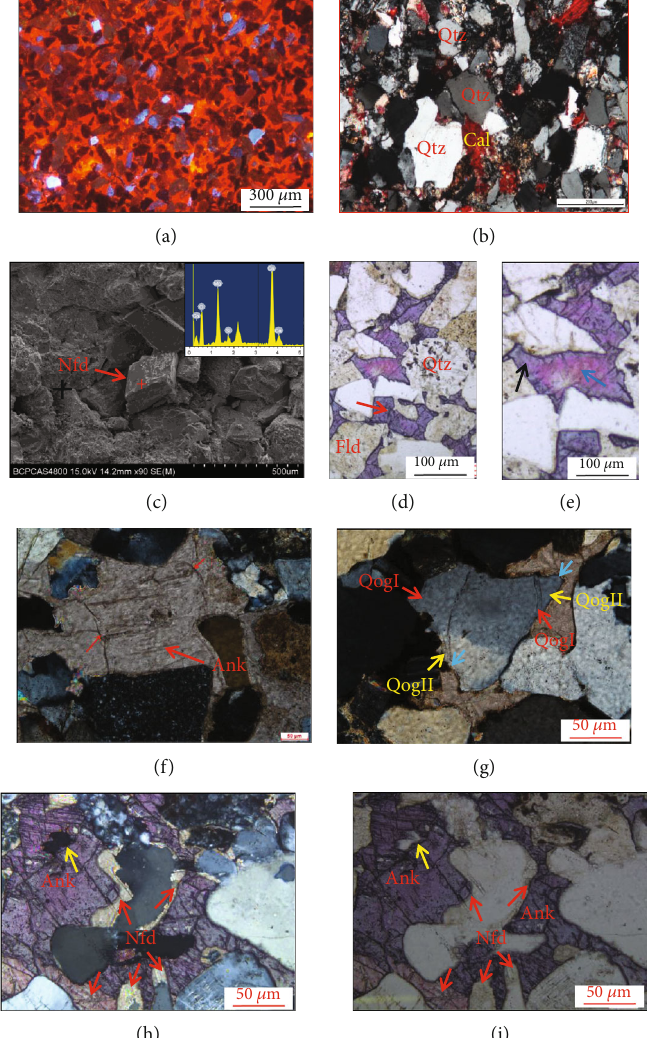
Figure 4: Diagenetic characteristics of the Es sandstones in Raoyang Sag. (a) Well L101: 3644.7m, a large deal of intergranular calcites acting 3 as orange cathodoluminescence, CL. (b) Well N35: 3758.7m, microcrystalline aggregates of calcite cements stained to be red, XPL. (c) Well NG4: 4680.0m, rhombic euhedral nonferroan dolomite fi lling in intergranular pore, SEM. (d) Well L101: 3804.5m, coarse-grained ankerites stained purple (red arrow) fi lling intergranular pores and replacing framework grains, PPL. (e) Well L101: 3804.5m, late ankerite stained purple (black arrow) replacing early calcite stained red (red arrow), PPL. (f) Well L101: 3804.5 m, ankerite cements replacing original quartz grain completely, XPL. (g) Well L101: 3804.20m, two generations of quartz overgrowths developed around detrital quartz grain, QogI (red arrow) developed continuously and QogII (yellow arrow) developed discontinuously, and engulfed by ankerite (blue arrow), meaning it is prior to ankerite, XPL. (h, i) Well C47: 3628.5m, ankerite fi lling intergranular pores and replacing original quartz grains (yellow arrow), as well as nonferroan dolomite (red arrows) engul fi ng quartz grains, XPL and PPL. Cal: calcite; Ank: ankerite; Qtz: quartz; Nfd: nonferroan dolomite; QogI: the fi rst generation of quartz overgrowths; QogII: the second generation of quartz